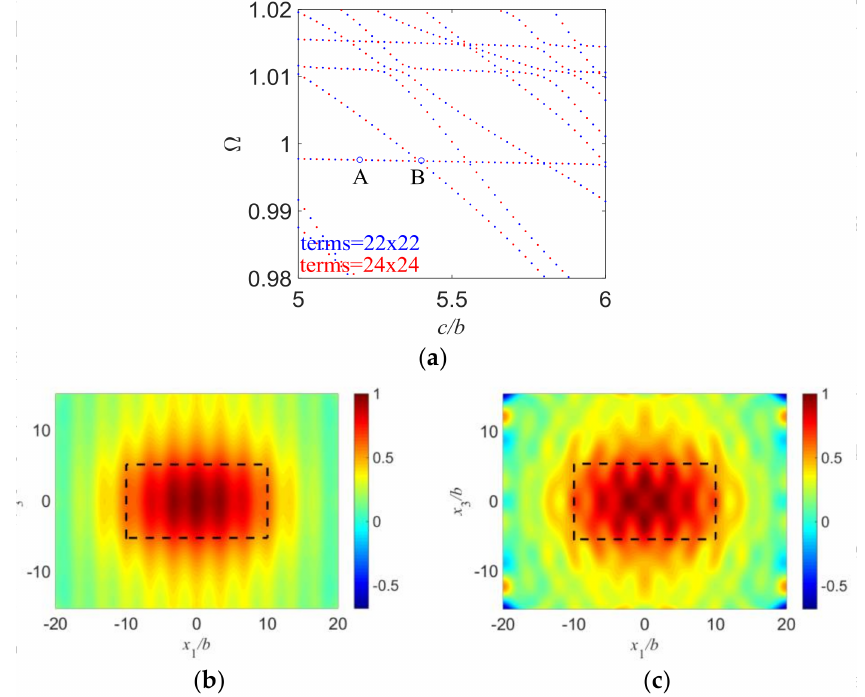
Figure 7. Influence of c/b on mode couplings. ( a ) Frequency spectra with different c/b when a / b = 10, d / b = 10, R = 0.01; ( b ) Point A: c/b = 5.20, a / b = 10, d / b = 10, R = 0.01, Ω = 0.99759004; ( c ) Point B: c/b = 5.40, a / b = 10, d / b = 10, R = 0.01, Ω =